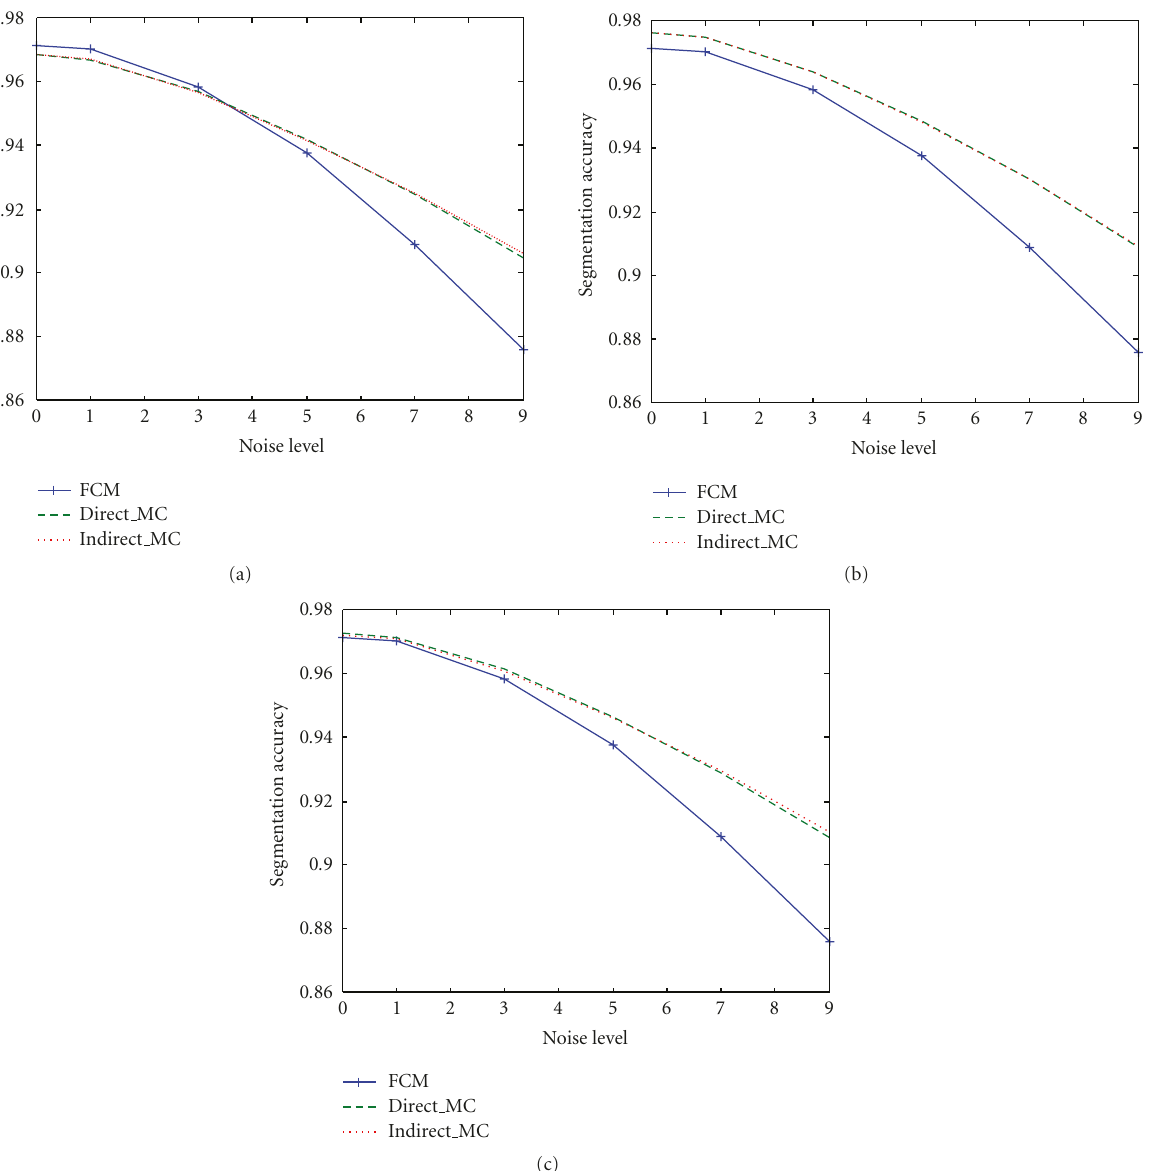
Figure 3: Segmentation accuracy of brainweb datasets of di ff erent noise levels: (a) with automatic seed selection, (b) with simulated manual seed selection (optimum seeds), (c) with automatic seed selection after specialization of the algorithm for CSF